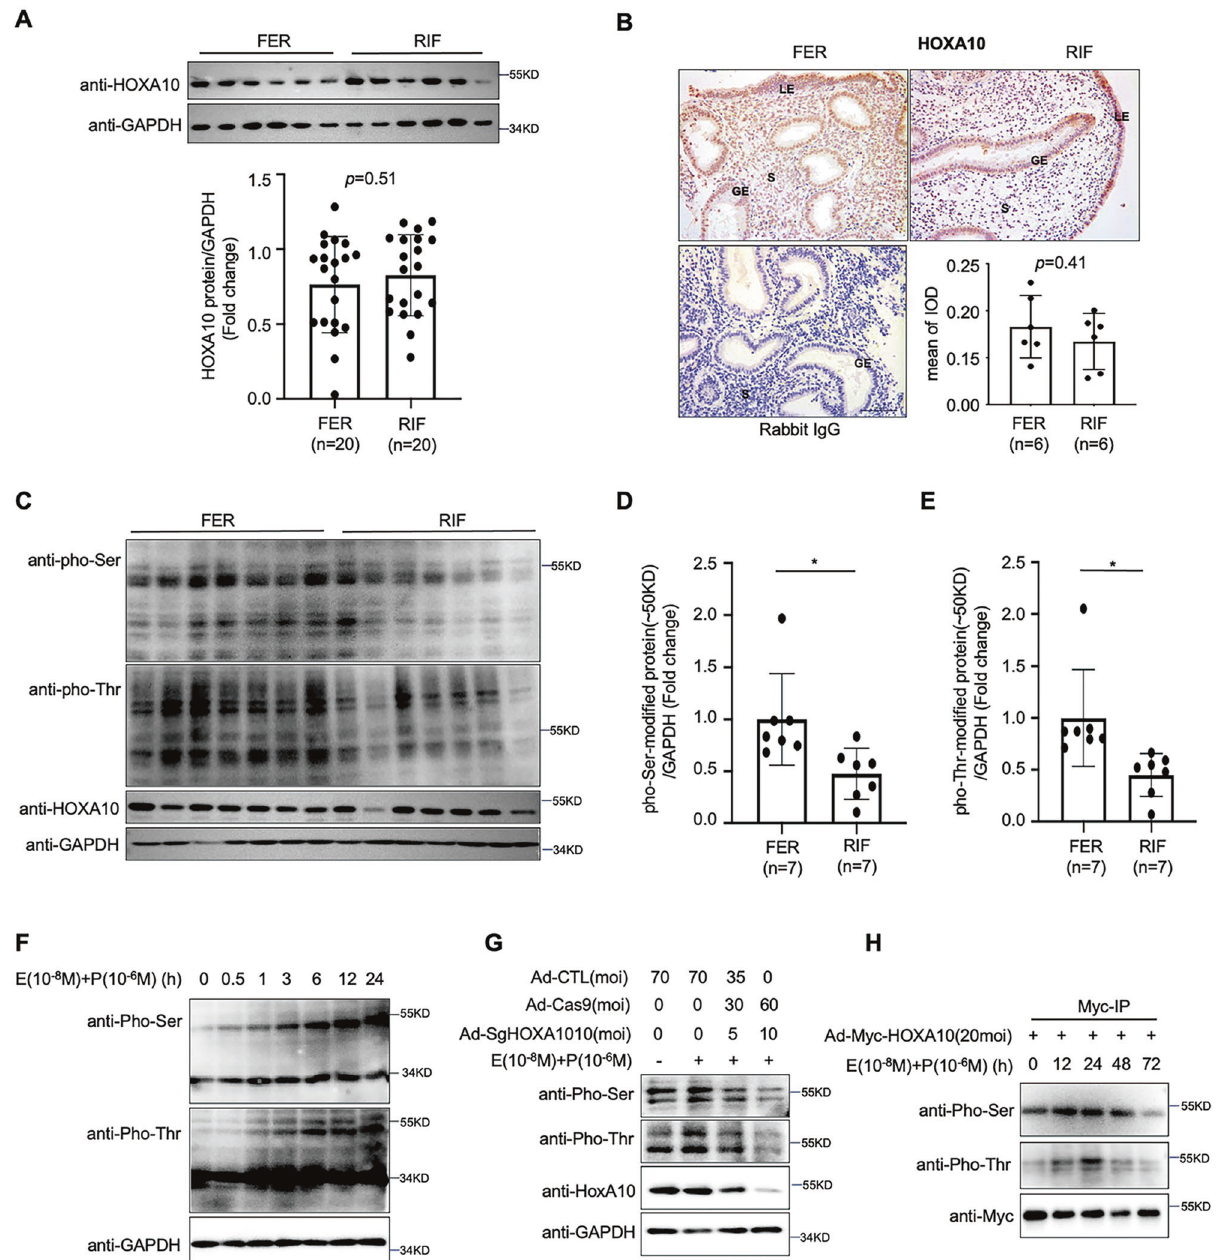
Fig. 1 Estrogen and progesterone promote HOXA10 protein phosphorylation in endometrial epithelial cells. A Western blotting analysis of HOXA10 expression in the endometria of normal control women ( n = 20) and infertile women with RIF ( n = 20). HOXA10 protein levels were normalized to GAPDH protein expression levels to quantify the densitometric analysis results. Data are represented as mean ± SEM, using t - test. B Immunohistochemical analysis of the HOXA10 expression in endometria from fertile women ( n = 6) and RIF patients ( n = 6). Rabbit IgG was used as a negative control. The IOD of HOXA10 expression was calculated with Image-Pro Plus (200× magni fi cation; scale bar = 100 µm). C Western blotting analysis of HOXA10, pho-Ser, and pho-Thr expression in endometria from normal control women ( n = 7) and infertile women with RIF ( n = 7). D , E pho-Ser and pho-Thr protein (~50 KD) levels were normalized to the GAPDH protein expression levels. Data are represented as mean ± SEM, * P < 0.05, using t -test. F Western blotting analysis of pho-Ser, and pho-Thr expression in Ishikawa cells treated with E 2 and MPA for various times as indicated. G Western blotting analysis of HOXA10, pho-Ser, and pho-Thr expression in Ishikawa cells infected with the adenoviruses Ad-cas9 and Ad-SgHOXA10 were treated with E 2 and MPA for 24 h. H Combination of Myc-IP with Western blotting analysis of pho-Ser, and pho-Thr expression in Ishikawa cells stimulated with the adenovirus Ad-Myc-HOXA10 and then treated with